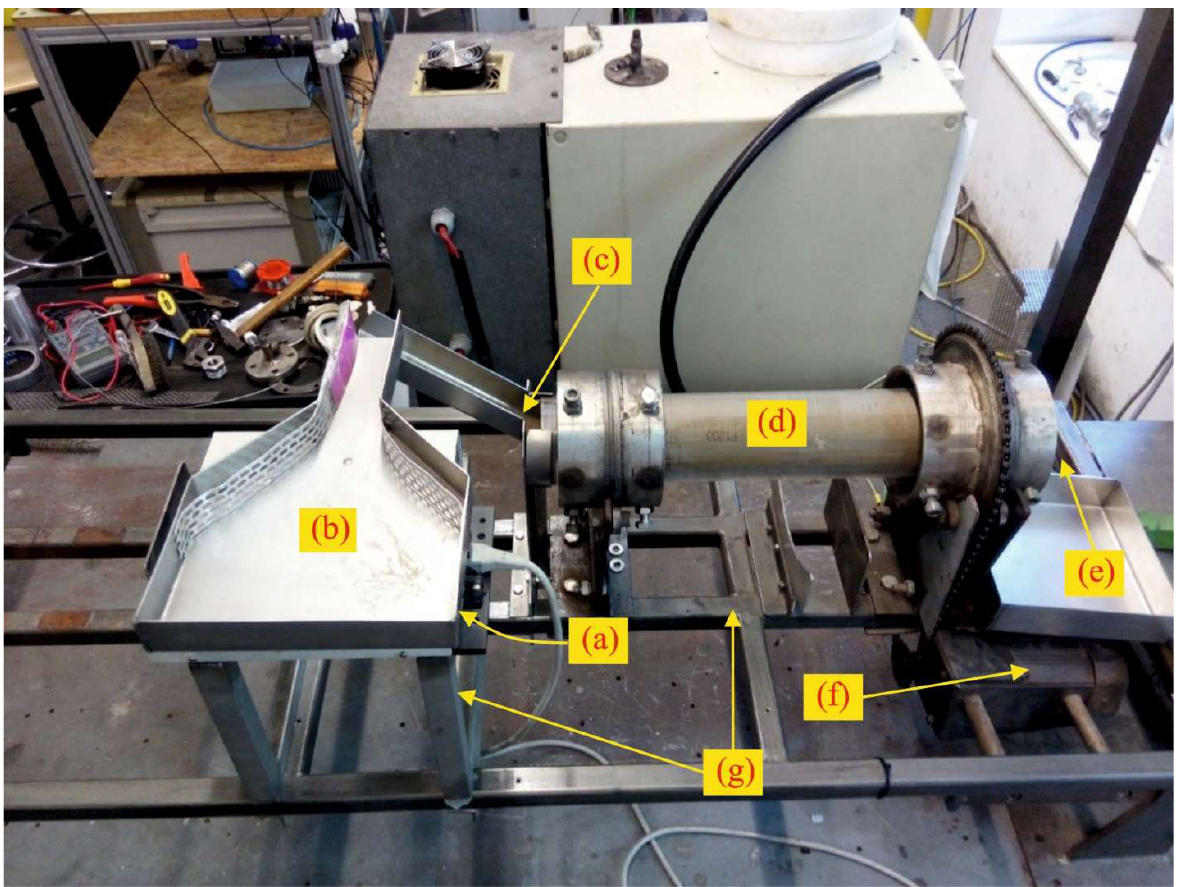
Figure 2 . Rotary drum setup and its parts: ( a ) vibrator ( b ) particle feeder ( c ) inlet of particles into drum ( d ) rotary drum ( e ) outlet of drum ( f ) motor ( g ) setup support.